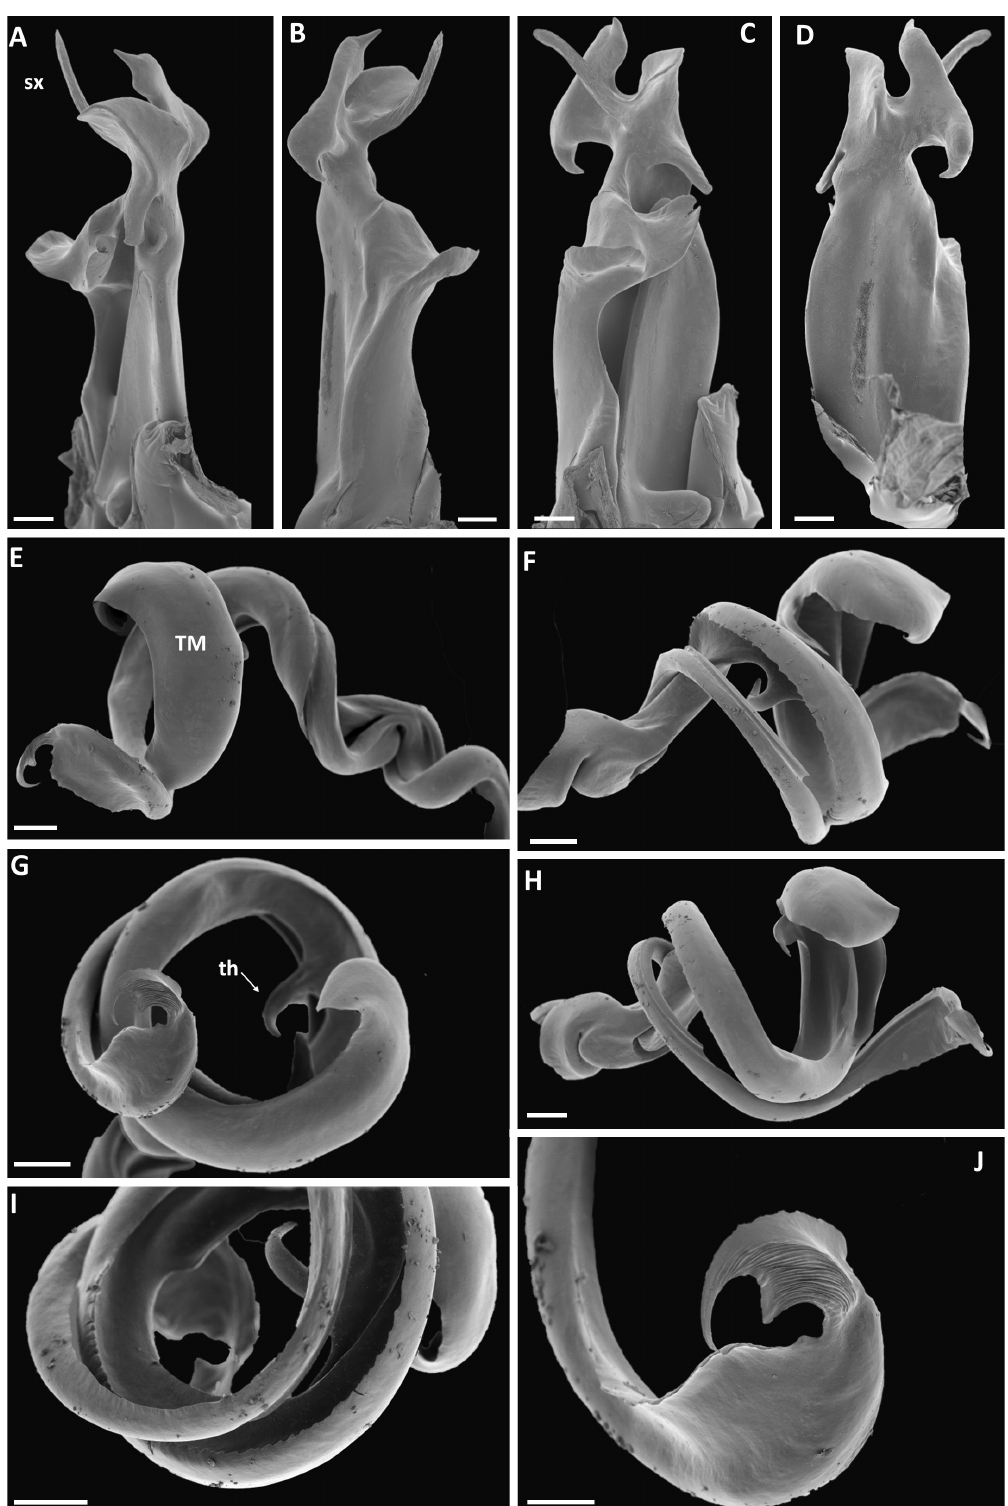
Fig. 65. Xystopyge robusta Attems, 1910, ♂, from Morogoro (HU-HR-124), right gonopod. A–D . Coxa. A. Anterior view. B. Posterior view. C. Mesal view. D. Lateral view . E–J . Telopodite. E. Anterior view. F. Posterior view. G. Mesal view. H. Ventral view. I. Lateral view. J. Tip of solenomere. Abbreviations: sx = slender metaplical process; th = telomeral hook; TM = telomere. Scale bars: A–I = 0.2 mm; J = 0.1